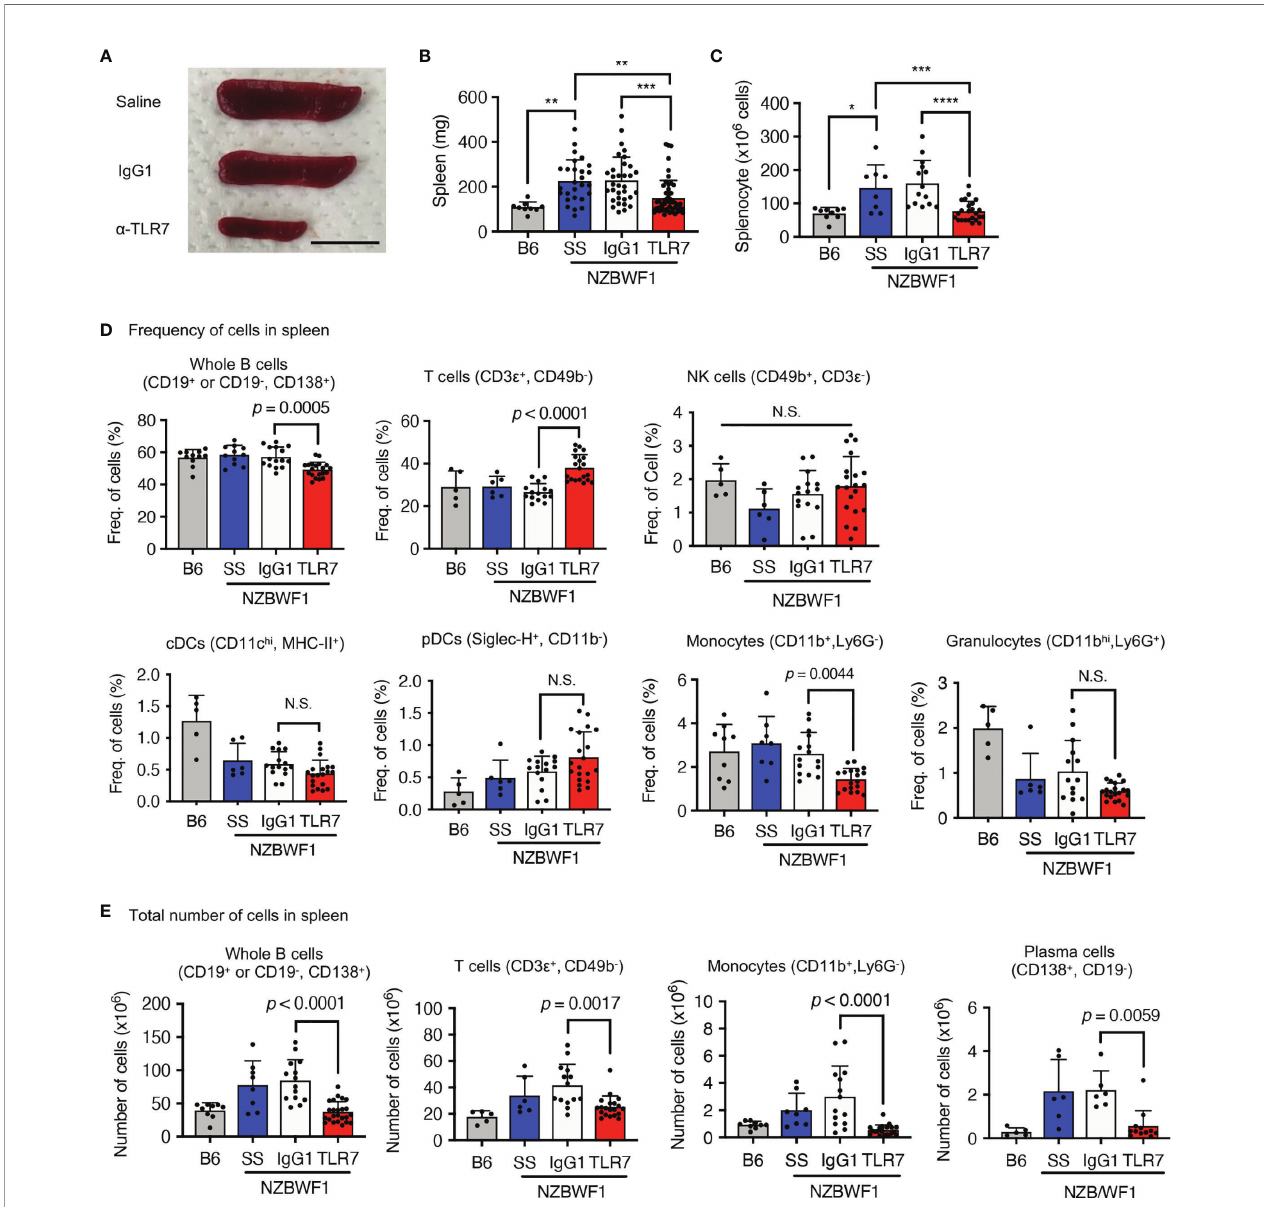
FIGURE 3 | Anti-TLR7 mAb inhibited monocytosis in spleens. (A-D) Age-matched B6 and NZBWF1 mice were administered saline, IgG1 or anti-TLR7 mAb from age of 12-16 to 35-40 weeks. (A-C) Macroscopic appearance (A) , weight (B) , and cell numbers (C) in spleens. B6 ( n = 9), saline ( n = 8), control IgG1 ( n ≥ 14), and anti-TLR7 mAb ( n ≥ 24). (D, E) Ratios (D) and absolute numbers (E) of indicated immune cells in spleens: B6 ( n ≥ 5), saline ( n ≥ 6), control IgG1 ( n ≥ 15), and anti- TLR7 ( n ≥ 18). Data were statistically analyzed using one-way ANOVA. The results found signi fi cant by ANOVA ( p < 0.05) were further assessed by Tukey ’ s multiple comparison tests (B, C) . For fl ow cytometry analysis, Tukey ’ s multiple comparison test was performed between control IgG1 and anti-TLR7 groups, and the p - values are shown (D, E) . * p < 0.05, ** p < 0.01, *** p < 0.001, **** p < 0.0001. N.S., not signi fi cant. Data are shown as individual points and as means ± SD for each experimental